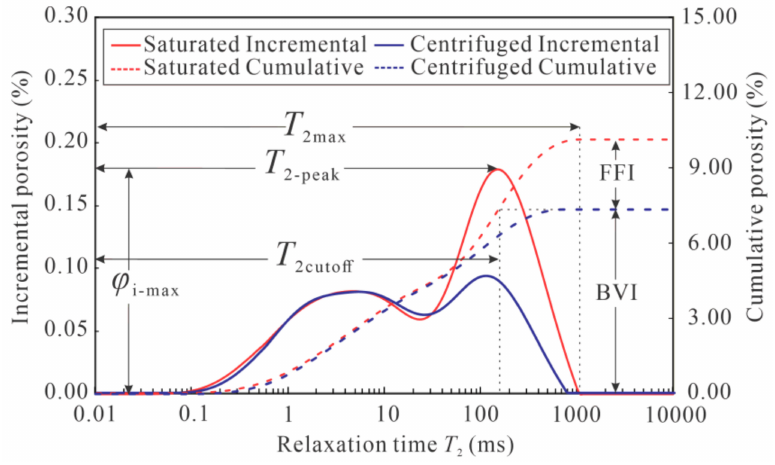
Figure A2. NMR T 2 spectral parameters and their locations in a NMR T 2 spectra.